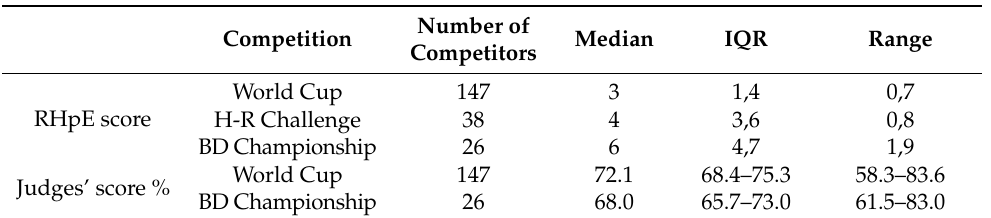
There were significant differences in the median RHpE scores among all three com- petitions. The median RHpE scores were significantly higher in the horses competing at the BD Championship compared with the H-R Challenge ( p = 0.0267), and WC competi- tions ( p = 0.0000). The H-R Challenge median RHpE score was also higher compared with WC competitions ( p = 0.0011) [10] (Table 5, Figure 2). Table 5. Comparison of Ridden Horse Pain Ethogram (RHpE) scores (0–24) at the World Cup Grand National Championship. Judges’ percentage (%) scores are also compared between the World Cup competitions and the BD Championship. IQR = interquartile range.